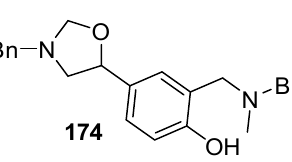
Figure 2. The bis adduct isolated from the reaction of 4-hydroxybenzaldehyde ( 2t , Table 23, entry 16). Table 23. Cycloaddition of azomethine ylide 172 , formed from silylamine reagent 178 , with aromatic aldehydes 2 (Scheme 45).